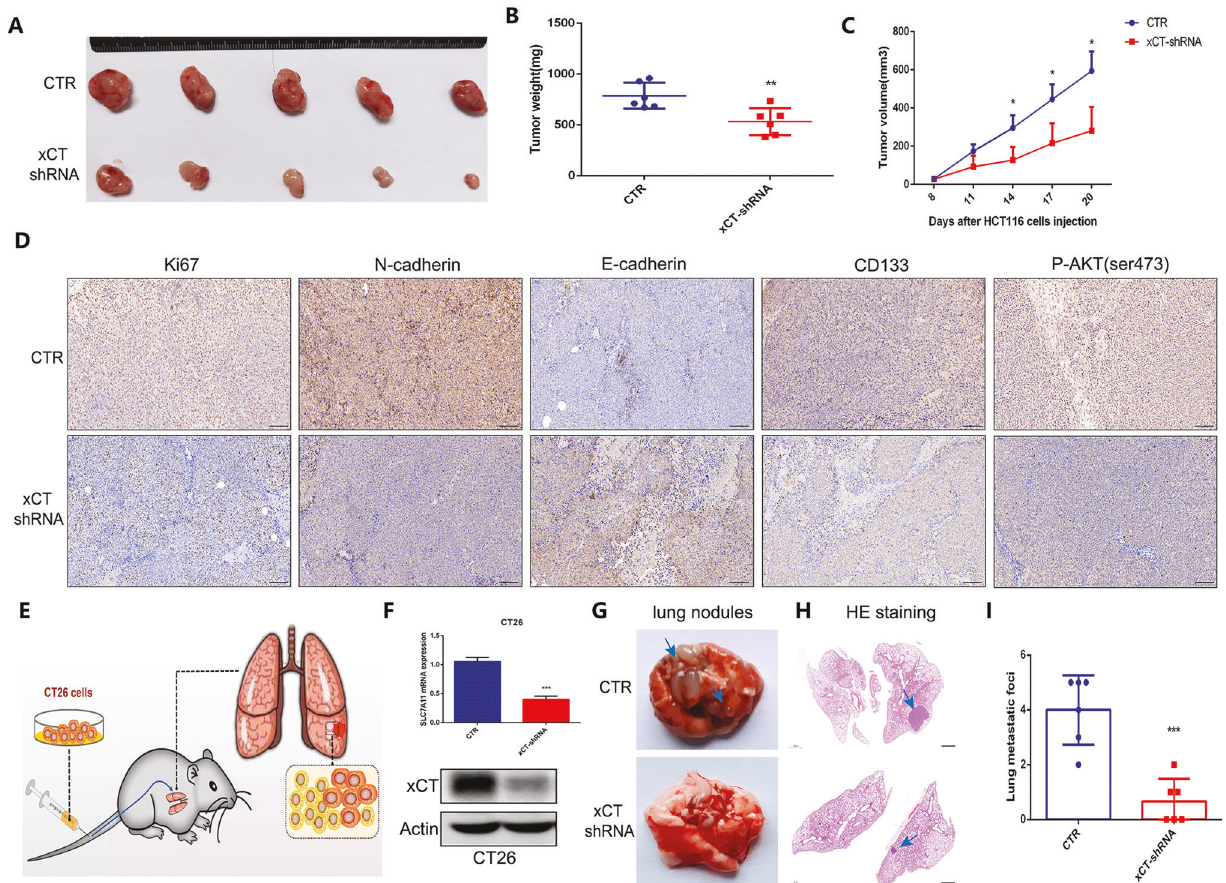
Fig. 5 Silencing of xCT suppresses CRC growth and blocks spontaneous lung metastasis of CRC cells. A xCT knockdown inhibited the growth of tumors in CRC xenograft mouse models. Differences in tumor weight ( B ) and volume ( C ) in nude mouse CRC models subcutaneously injected with HCT116 cells with or without xCT inhibition. D IHC staining showed the changes in the expression of Ki67, N- cadherin, E-cadherin, CD133 and P-AKT in CRC tissues after xCT knockdown. E The process to establish a CRC lung metastasis mouse model. F qRT-PCR and western blotting assays con fi rmed the knockdown ef fi ciency with xCT shRNA administration in CT26 cells. Macroscopic changes in the lungs ( G ) and pathological changes in the lung tissues ( H ) of mice after caudal vein injection of CT26 cells with or without xCT inhibition. I xCT knockdown signi fi cantly inhibited the metastatic capability of CRC. * P < 0.05, ** P < 0.01, *** P <